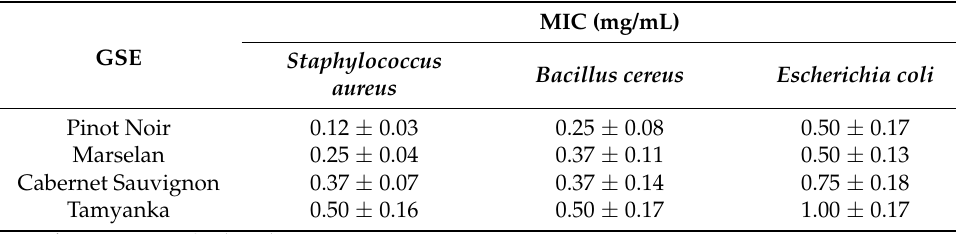
Table 6. Minimum inhibitory concentration (MIC) of grape seed extract (GSE) against pathogenic